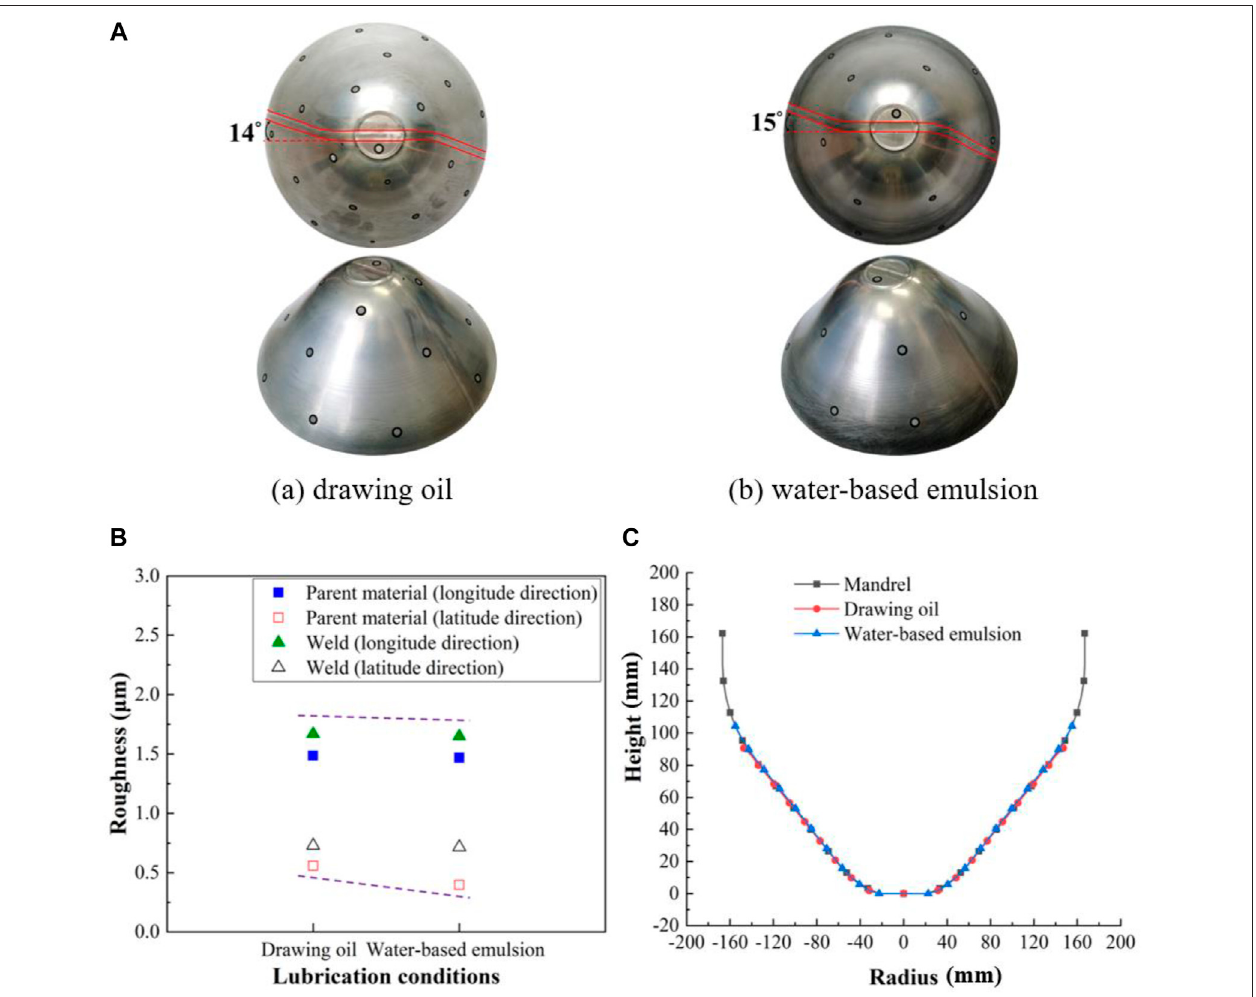
FIGURE 11 | Experimental results: (A) top and oblique views of spun parts under the lubrication conditions of (a) drawing oil and (b) water-based emulsion; (B) surface roughnesses of spun parts and (C) forming pro fi le of spun parts.